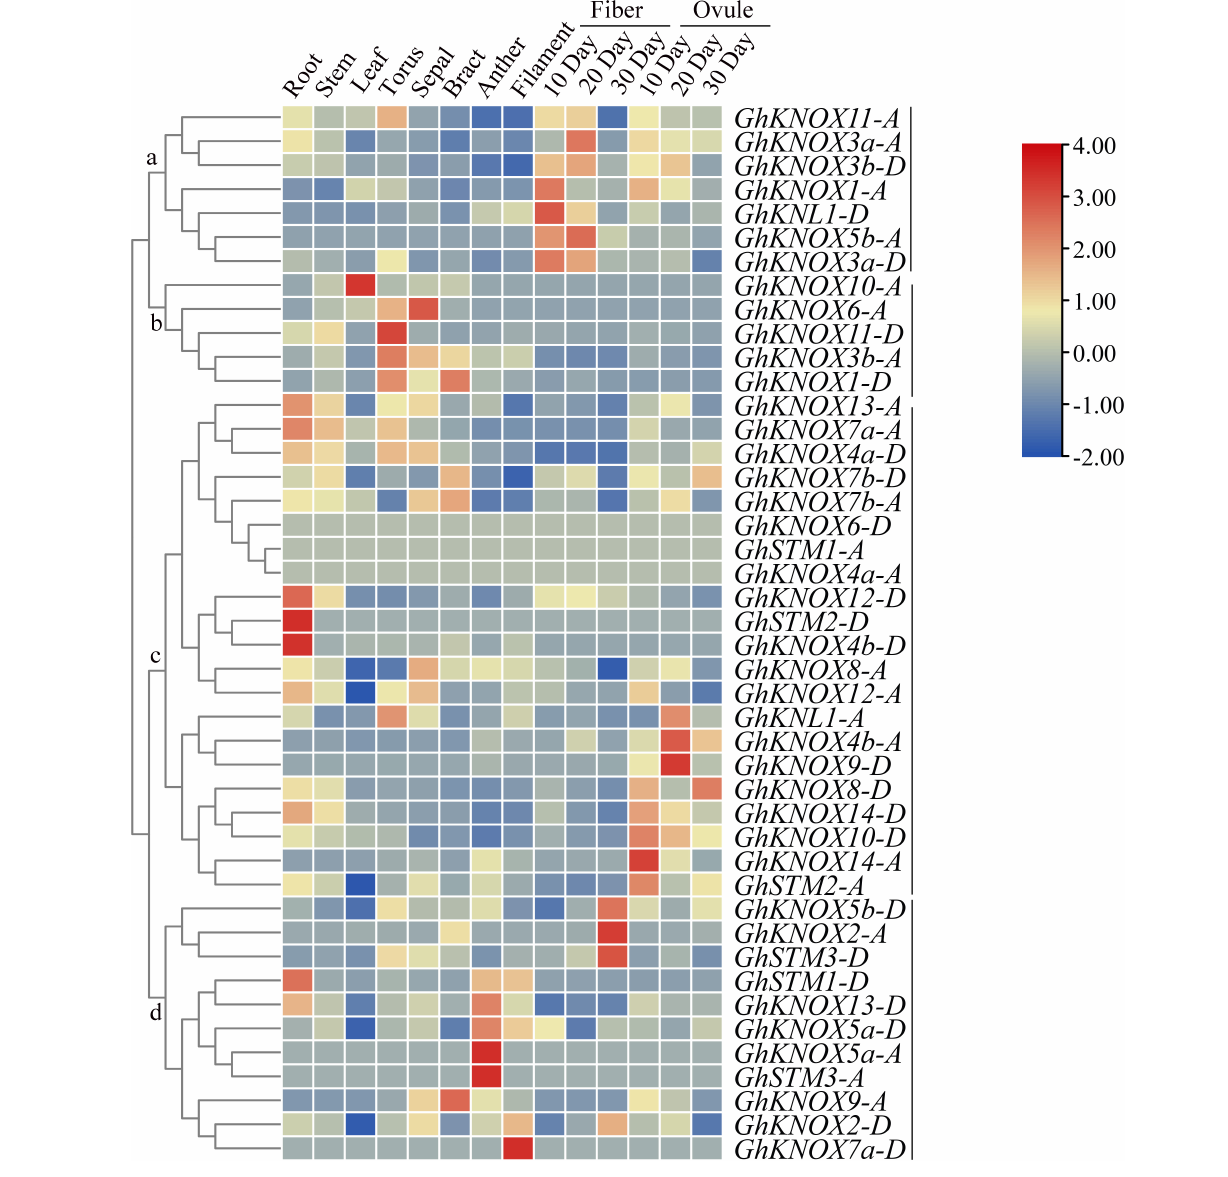
FIGURE 5 | Expression patterns of GhKNOX genes in different tissues. The expression patterns were analyzed using hierarchical clustering. The FPKM values were calculated from RNA-seq data and are shown as a heatmap. The colored scale indicates the relative expression